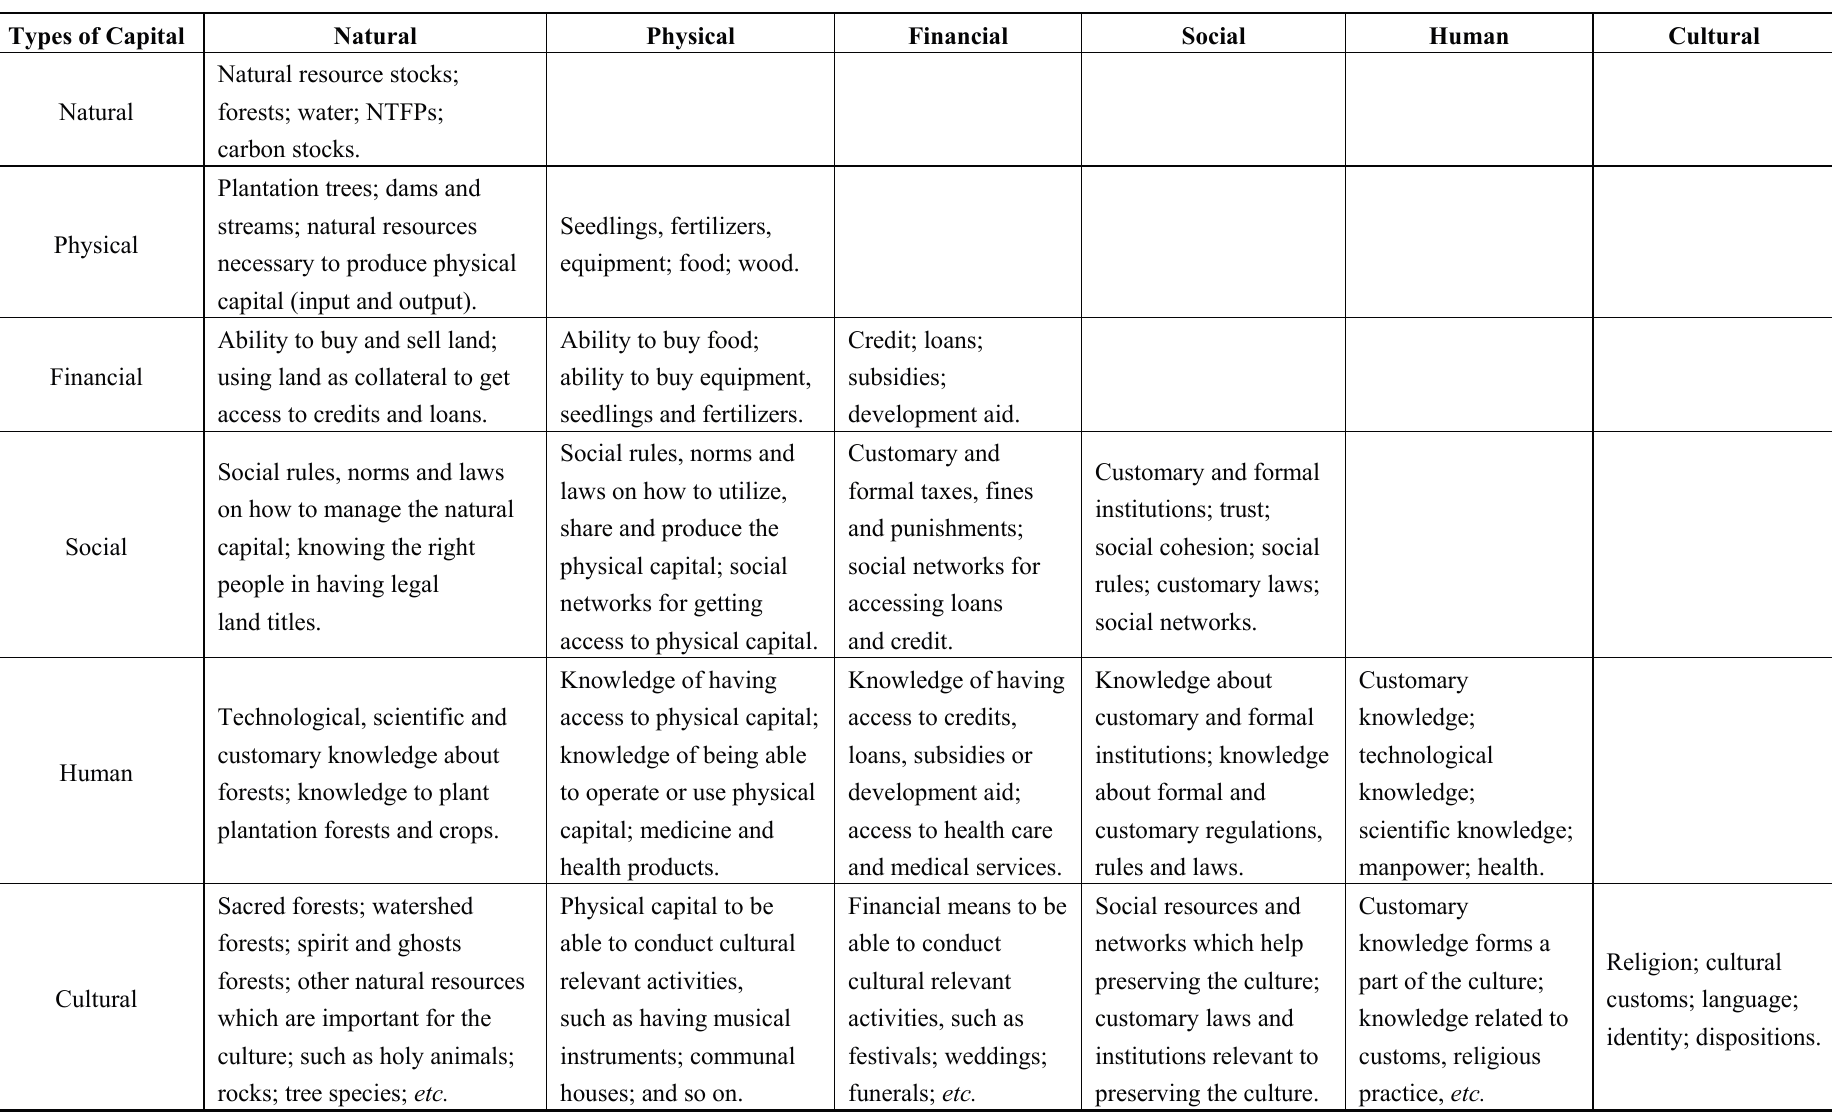
Table 6. Sustainable livelihoods framework for REDD+ and